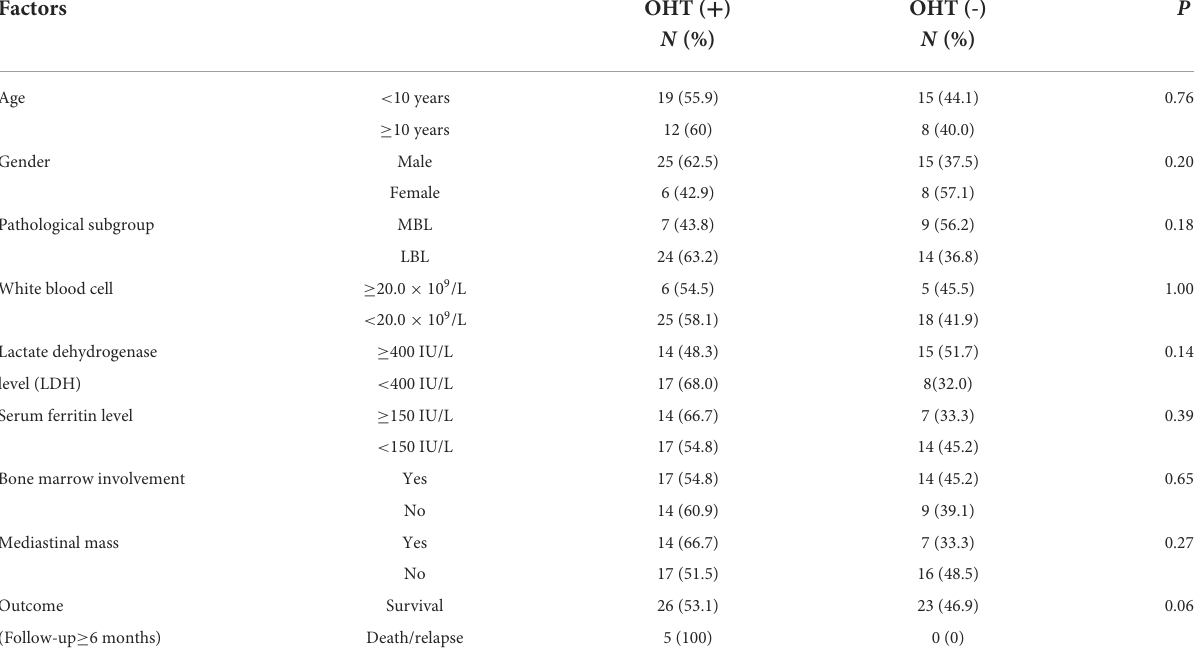
TABLE 1 Analysis of the risk factors on the development of OHT. Factors